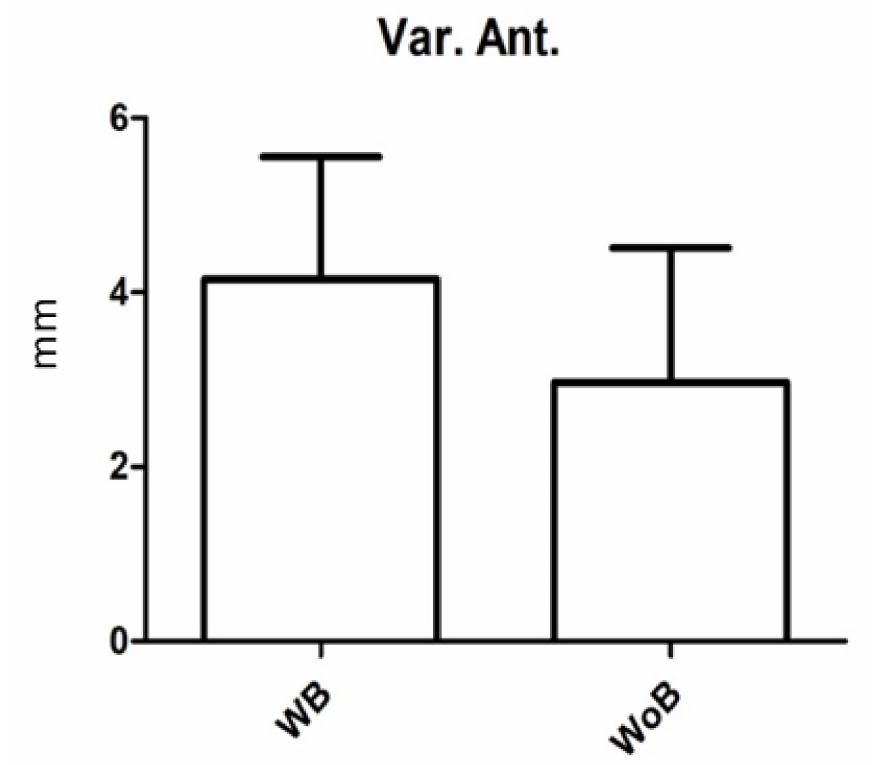
Figure 3. Variation of the anteroposterior oscillation (mm) in the baropodometric measurement with (WB) and without (WoB) a brace. Error bars represent Standard Error (SE).